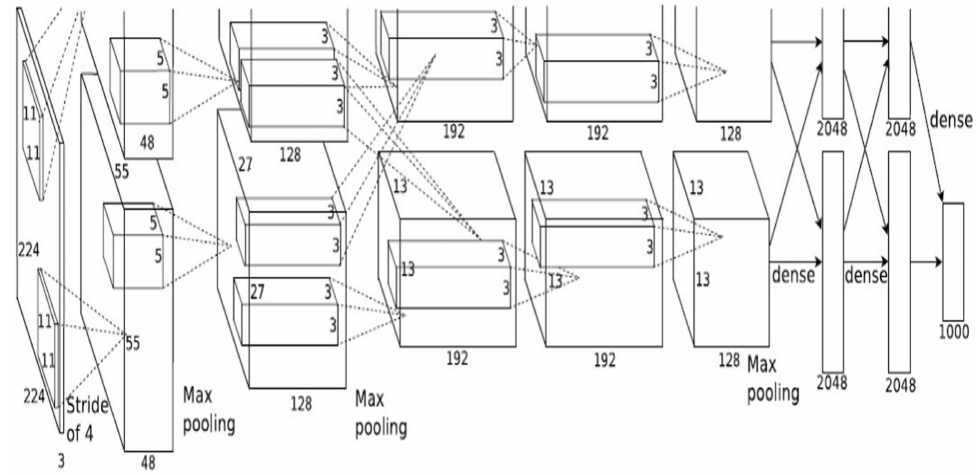
Figure 2. AlexNet architecture